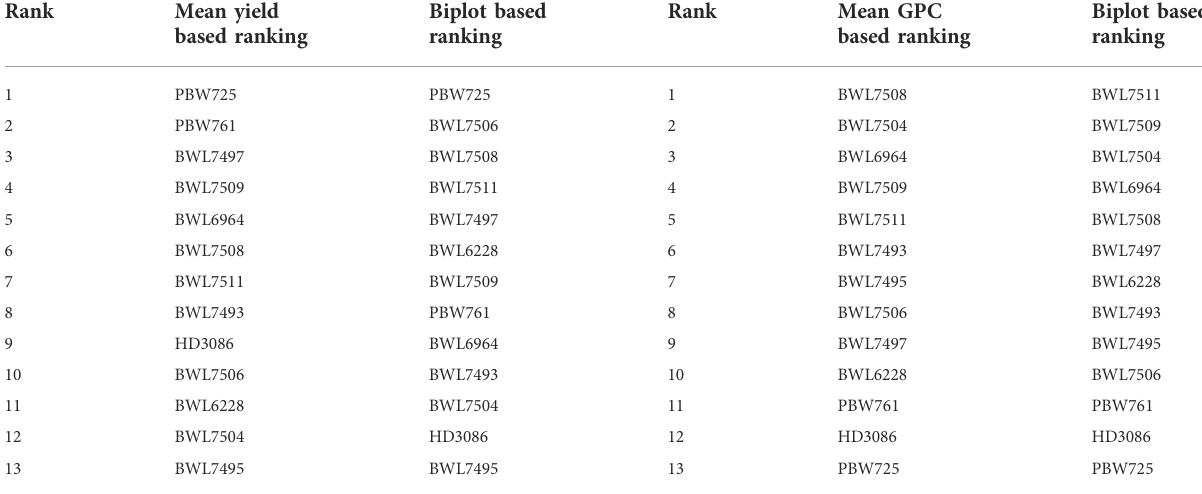
TABLE 6 Ranking of 13 bread wheat genotypes based on yield and GPC mean and biplot decision. Rank Mean yield based ranking